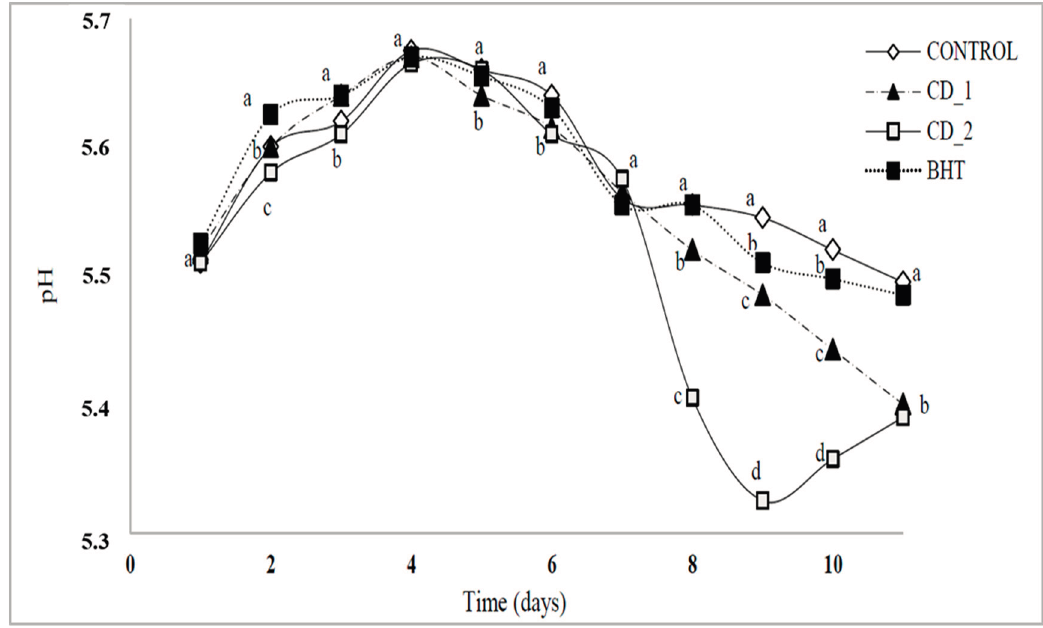
Figure 5. Effects of Caesalpinia Decapetala added at 0.1% and 0.5% ( w / w ) and BHT added at 0.01% ( w / w ) on the changes in pH values of raw beef patties. Data is presented